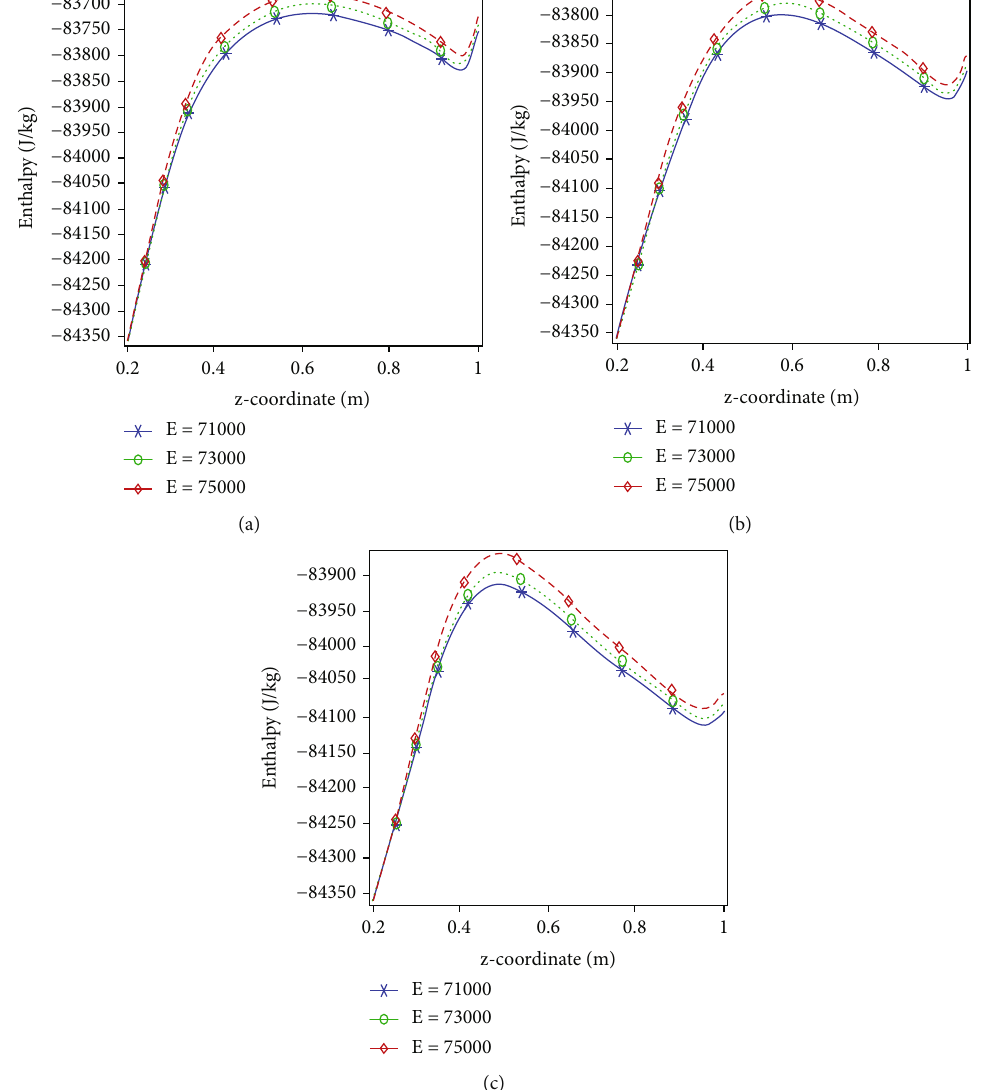
Figure 15: Measurement of enthalpy at downstream along the backstep channel against the axial direction at (a) Re = 100 , I : C = 3 % , a = 0 : 5 ; (b) Re = 100 , I : C = 3 % , a = 0 : 6 ; and (c) Re = 100 , I : C = 3 % , a = 0 : 7